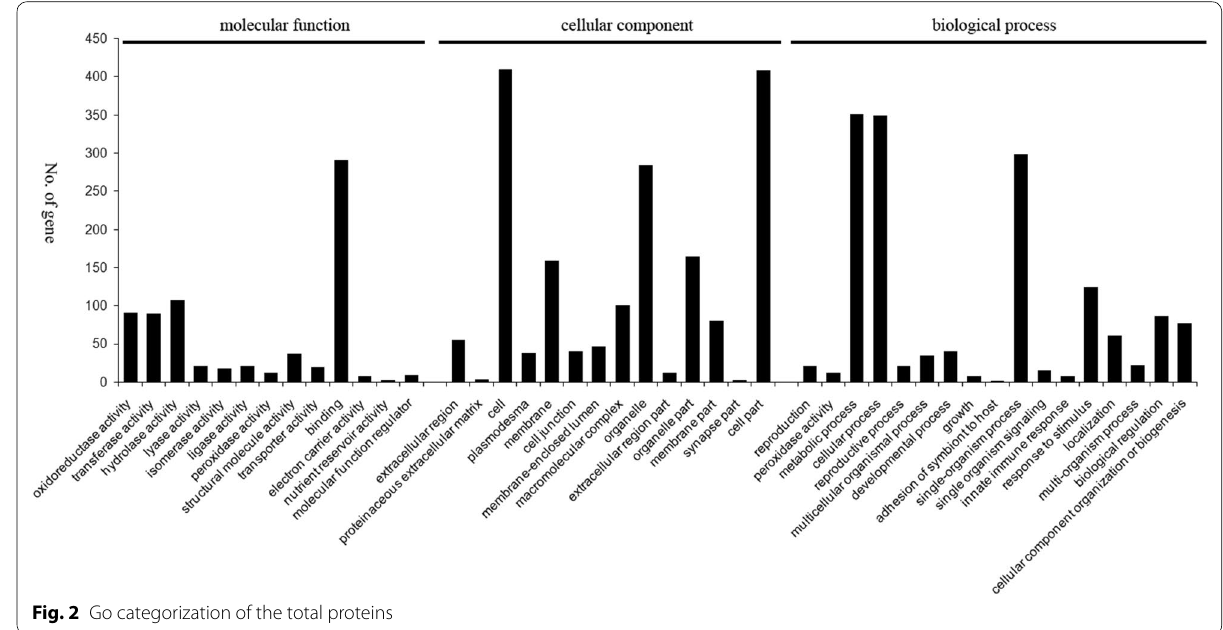
Fig. 2 Go categorization of the total proteins